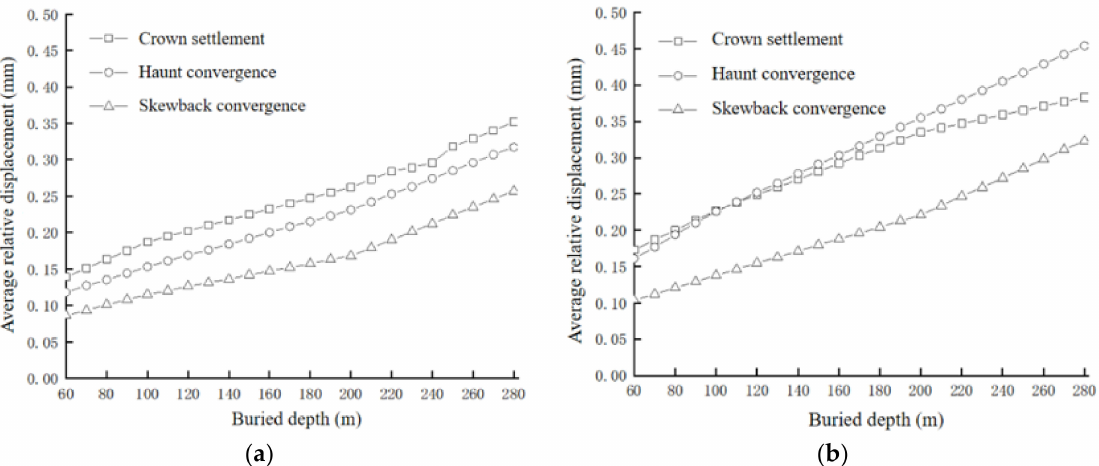
Figure 4. Relationship between the average relative displacement at different positions and the buried depth under different surrounding rock grades. ( a ) Grade IV surrounding rock; ( b ) Grade V surrounding rock.